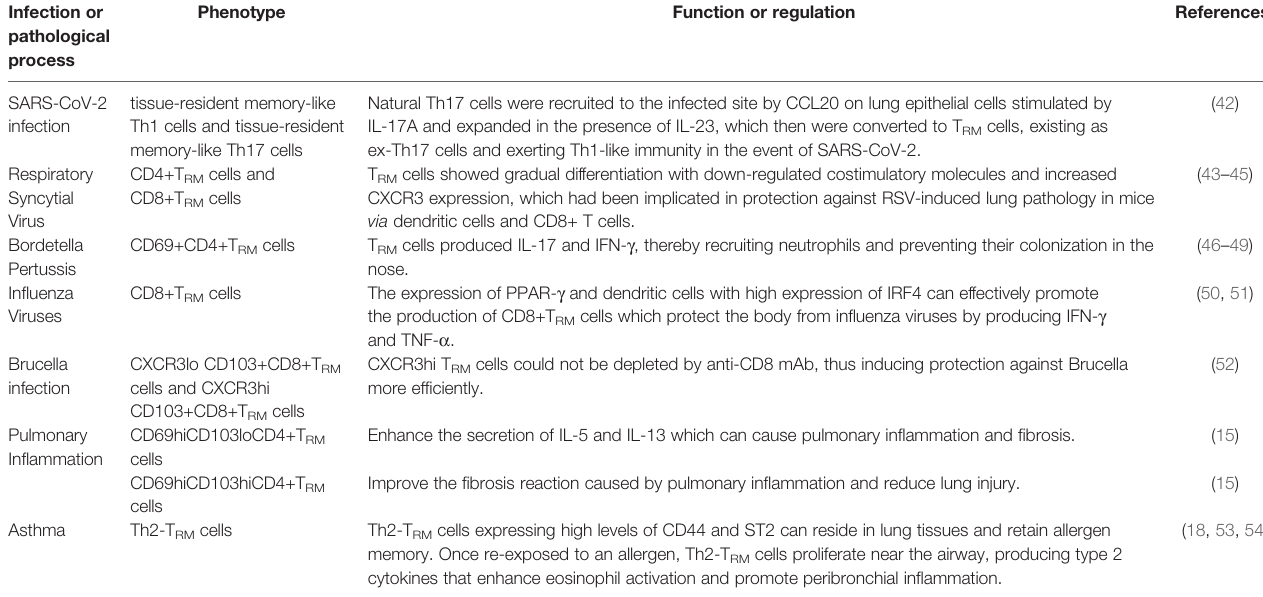
TABLE 2 | The features of T RM cells in lung infection or pathological process.